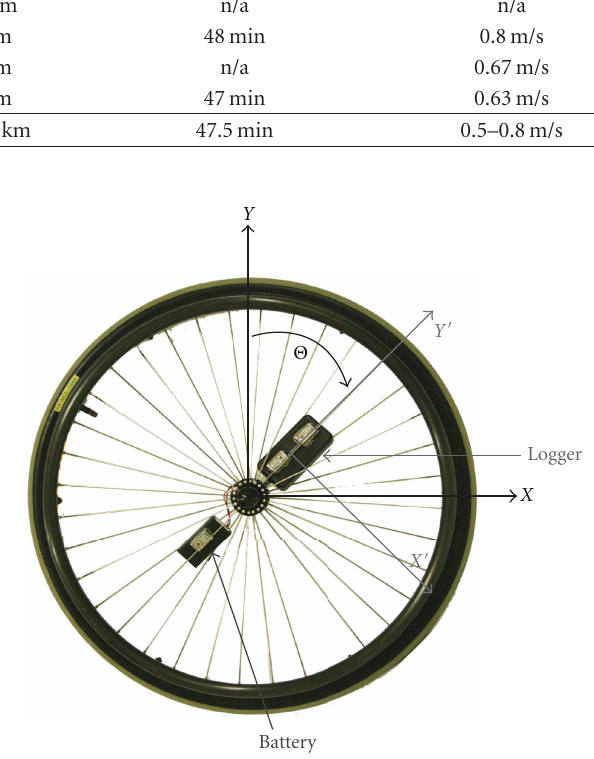
Figure 1: Spoked MWC wheel instrumented with the data logger and its corresponding battery pack. The data logger axes (X (cid:2) and Y (cid:2) ), oriented radially and tangentially, respectively, are parallel to the wheel plane (X and Y). Only this plane was analyzed. Acceleration along the third axis, perpendicular to the wheel plane, was not